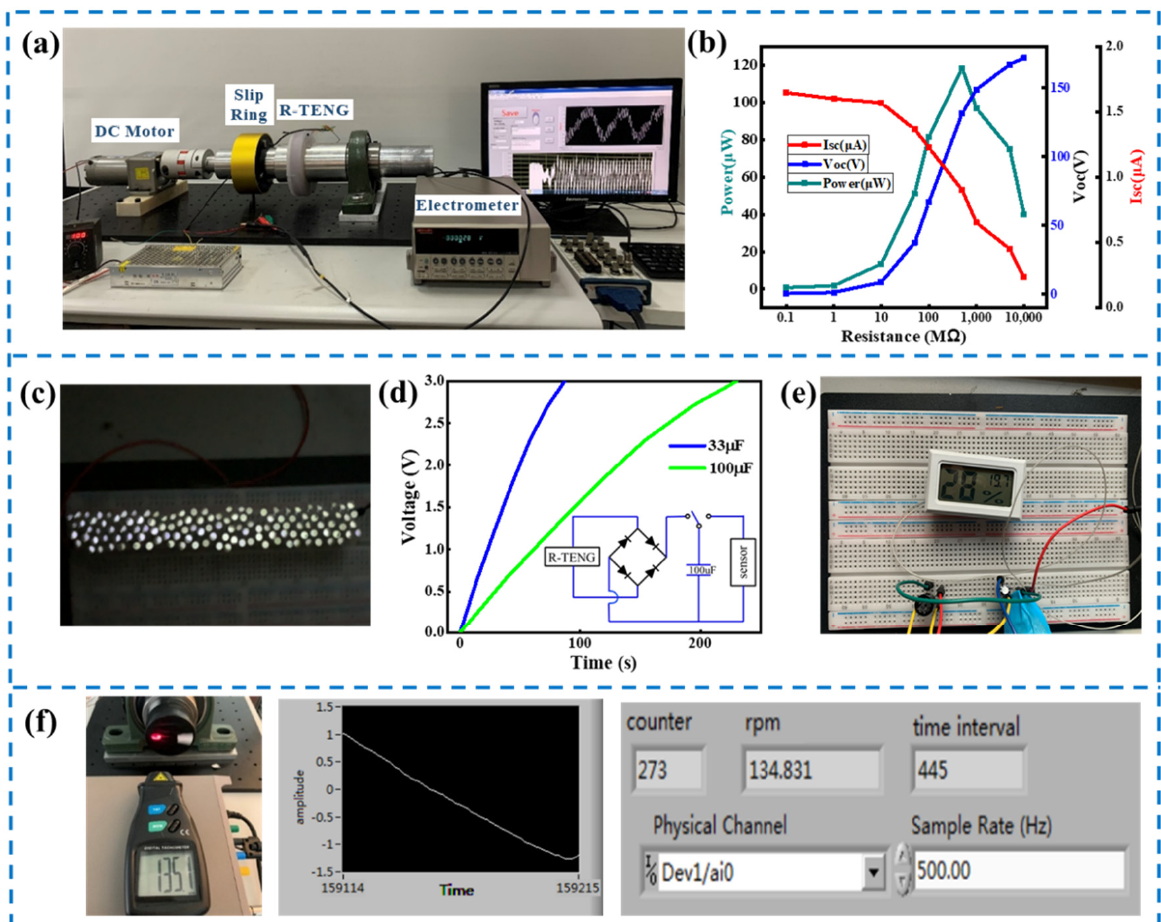
Figure 5. Demonstration of the R-TENG for energy harvesting and rotational speed measurement: ( a ) photograph of the test devices; ( b ) output voltage, current and power for the R-TENG with the resistance of the load; ( c ) photograph of 80 white LEDs powered by the R-TENG; ( d ) charging curve of different capacitors by the R-TENG electrical output; ( e ) photograph of a 100 µ F capacitor charged and supplying power to thermometer; ( f ) tests of rotational speed measurement by output voltage signal of the R-TENG via LabVIEW.